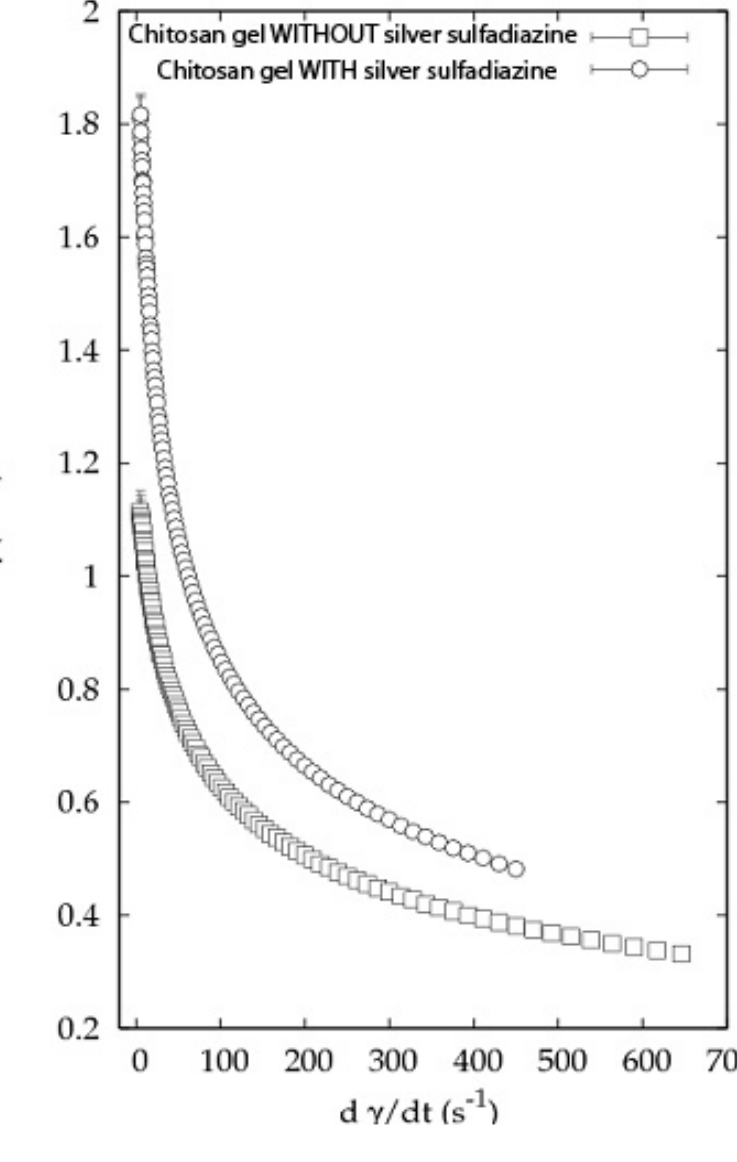
FIGURE 1 - Viscosity ( (cid:536) ) versus shear rate of chitosan gel without (squares) and with silver sulfadiazine